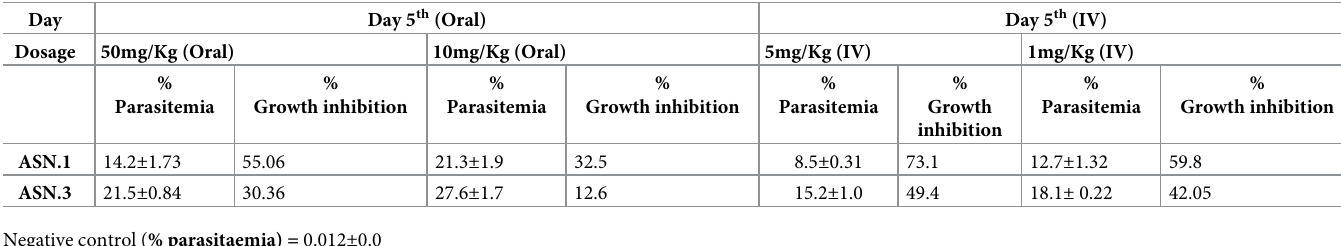
Table 4. Efficacy of Pf PMT inhibitors in P . berghei infected mice in terms of % growth